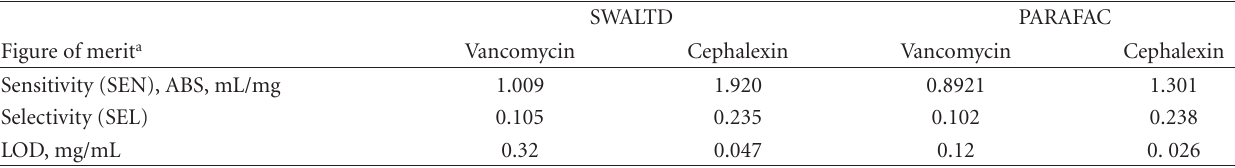
Table 2: Analytical figure of